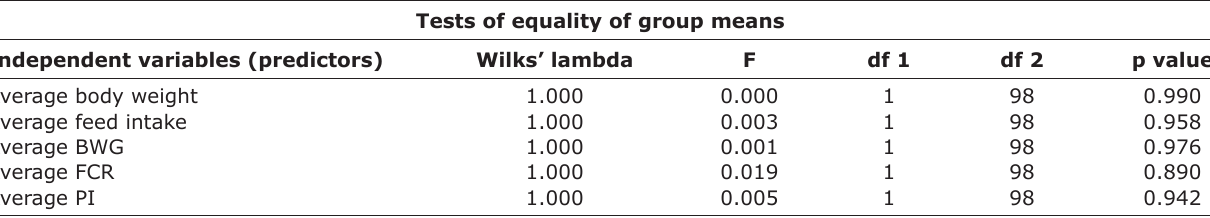
MANOVA=Multivariate analysis of variance Table-5: Tests of equality of group (Ross and Happer breeds) means using canonical discriminant function analysis. Tests of equality of group means Independent variables (predictors)